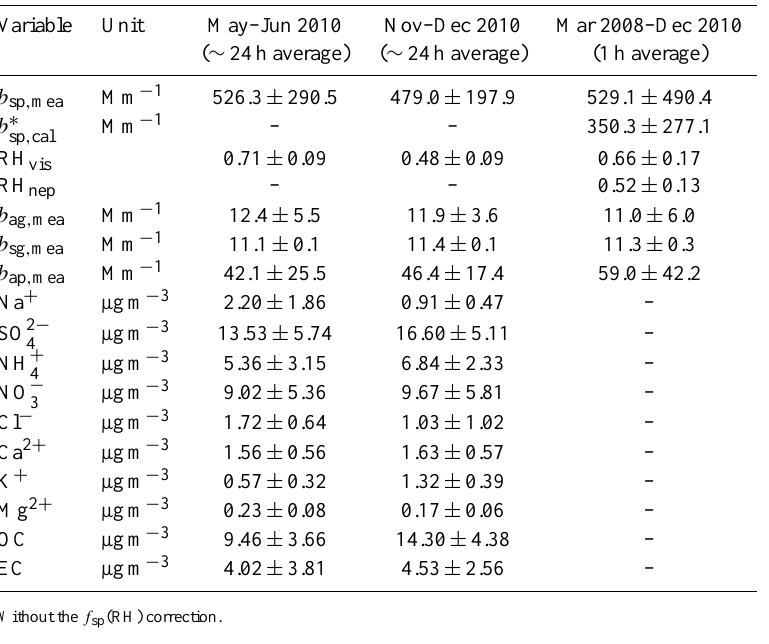
Table 4. Statistical results of fundamental data in the evaluation of f sp (RH).